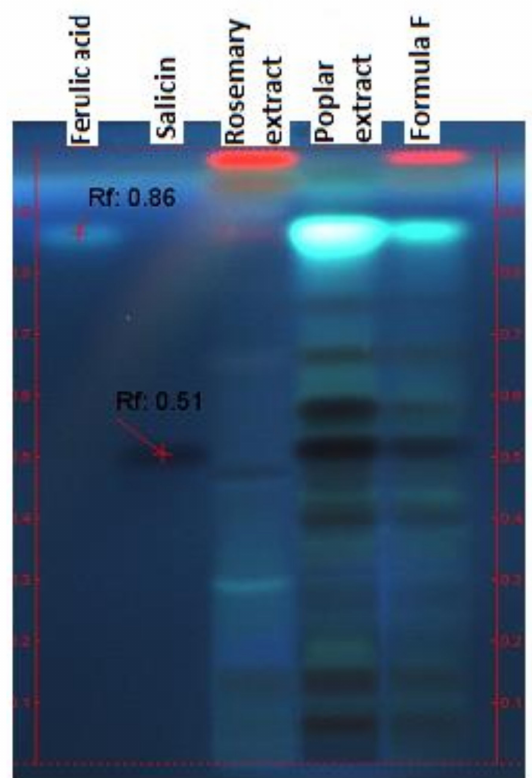
Figure 1. Identification of salicin by HPTLC, derivatization with 20% H 2 SO 4 (UV 366